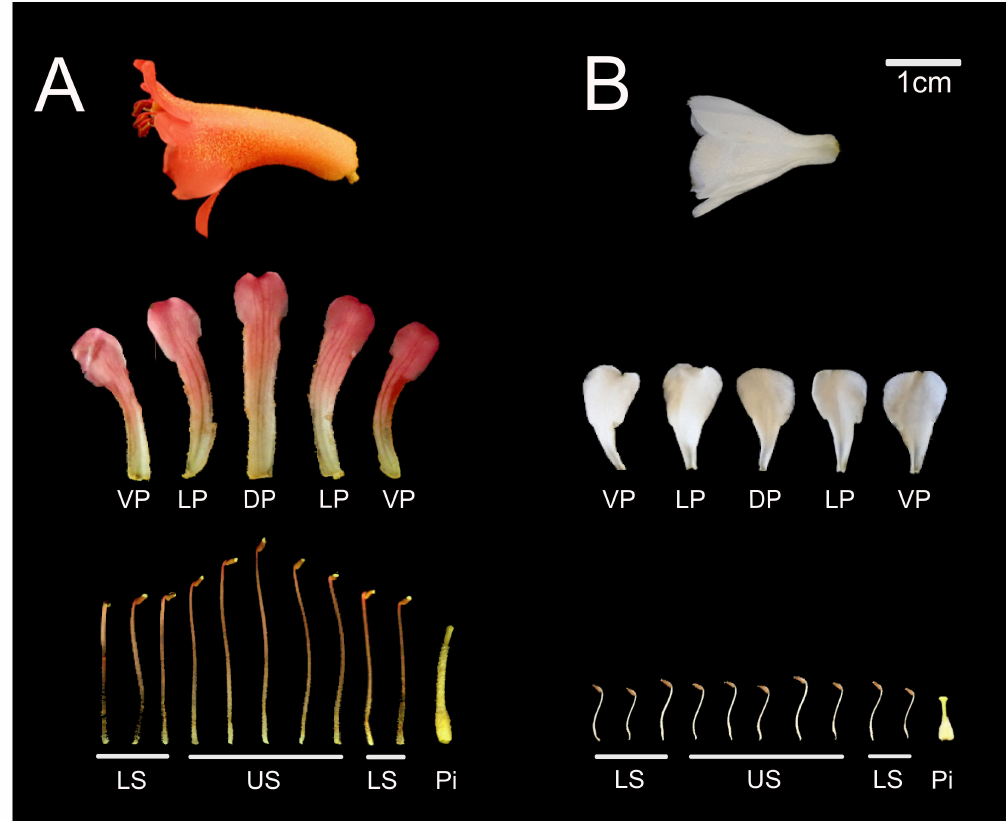
Figure 5. Morphology of open flowers in two Rhododendron species with different floral symmetries. ( A ) Bilateral flower of R. beyerinckianum . ( B ) Radial flower of R. taxifolium . Whole flowers are shown with the dorsal side toward the top. Dissected floral organs are shown below each flower: dorsal petal (DP), lateral petals (LP), ventral petals (VP), upper stamens (US), lower stamens (LS), and pistil